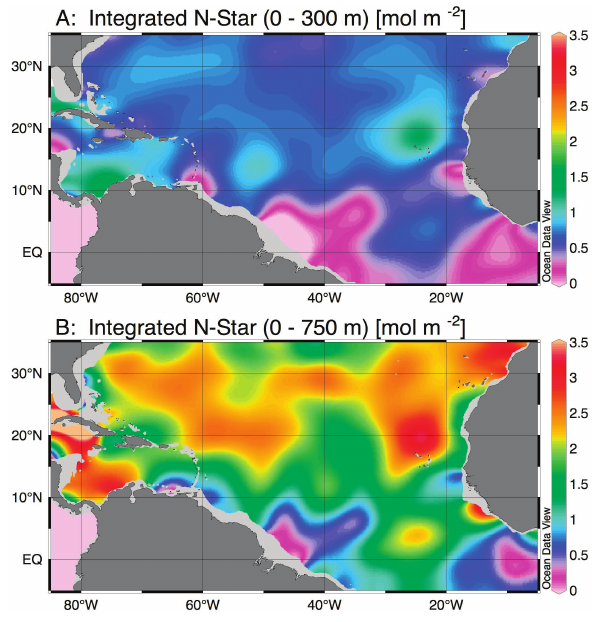
Fig. 4. Integrated N* values for the region covered in this study. N* values were calculated based on objectively analyzed 1 ◦ nutrient fields from the World Ocean Atlas 2001 (Conkright et al., 2002), then integrated vertically through the upper 300m (A) or 700m (B) of the water column using Ocean Data View (Schlitzer, 2005). These depth intervals were chosen to reflect the core (A) and the lower boundary (B) of the subtropical mode water in the western